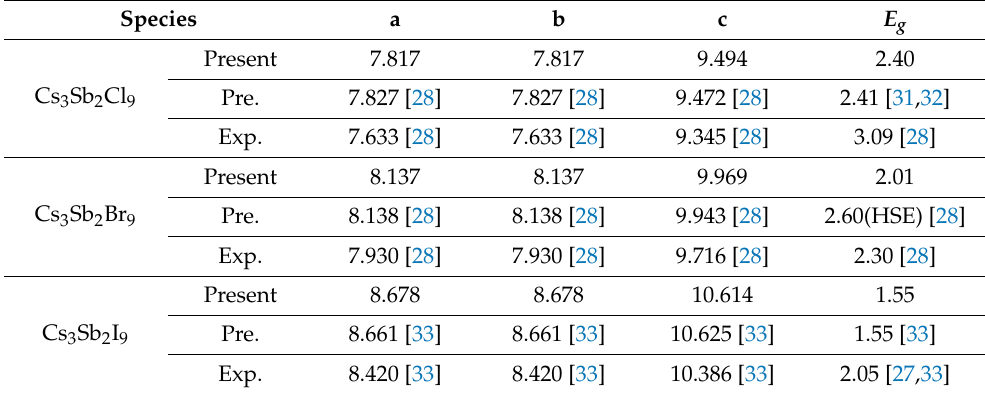
Table 1. Calculated results (Present), previous theoretical (Pre) and experimental (Exp) values of lattice parameters a, b, and c (Å), bandgap energy E g (eV) of Cs 3 Sb 2 X 9 . Species a b c E g Cs 3 Sb 2 Cl 9